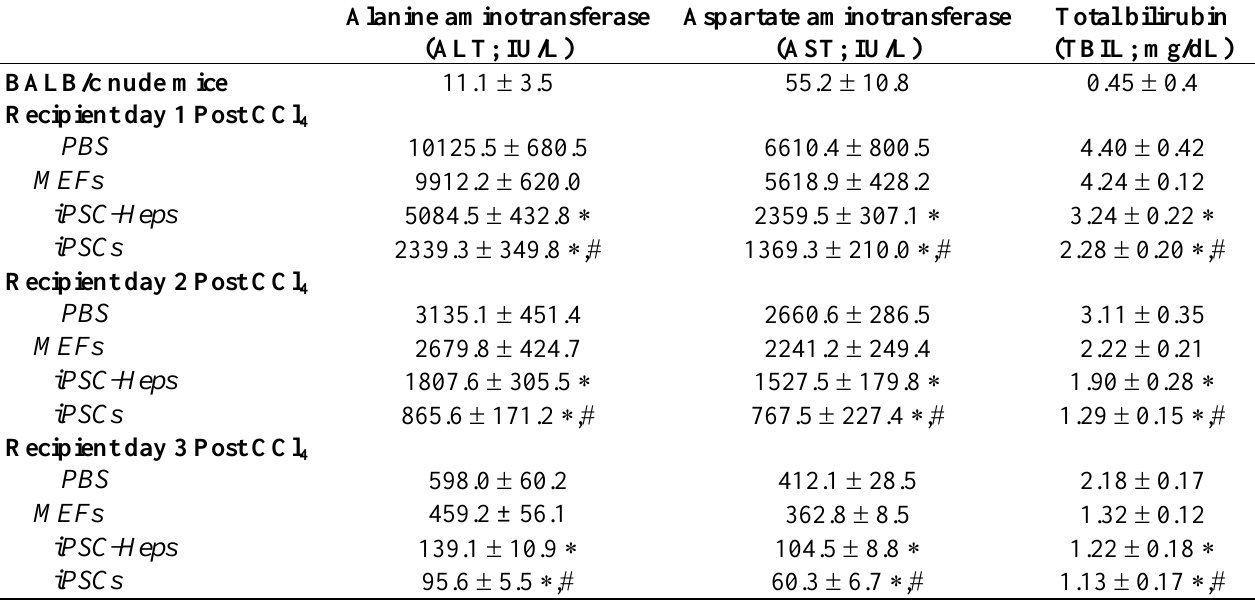
Table 1. Effect of intraperitoneal transplantation of mouse embryonic fibroblasts (MEFs), iPSC-Heps, or induced pluripotent stem cells (iPSCs) on hepatic biochemical parameters in CCl -treated 4